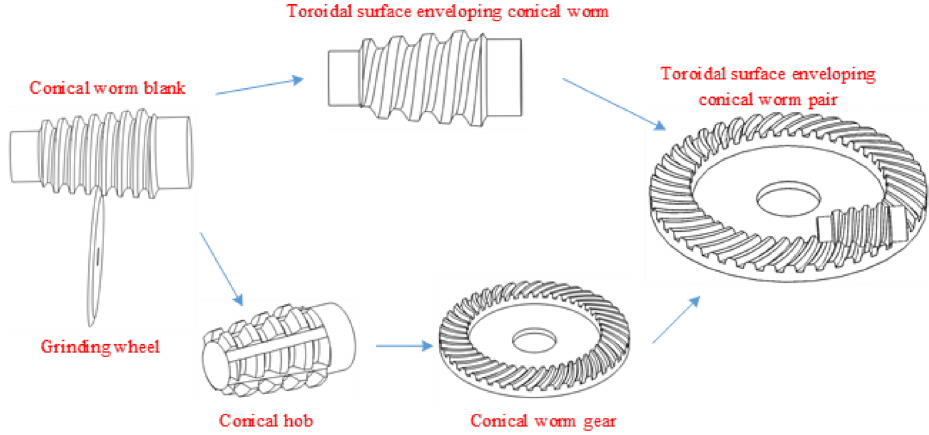
Figure 1. Schematic diagram of the toroidal surface enveloping conical worm gearing.